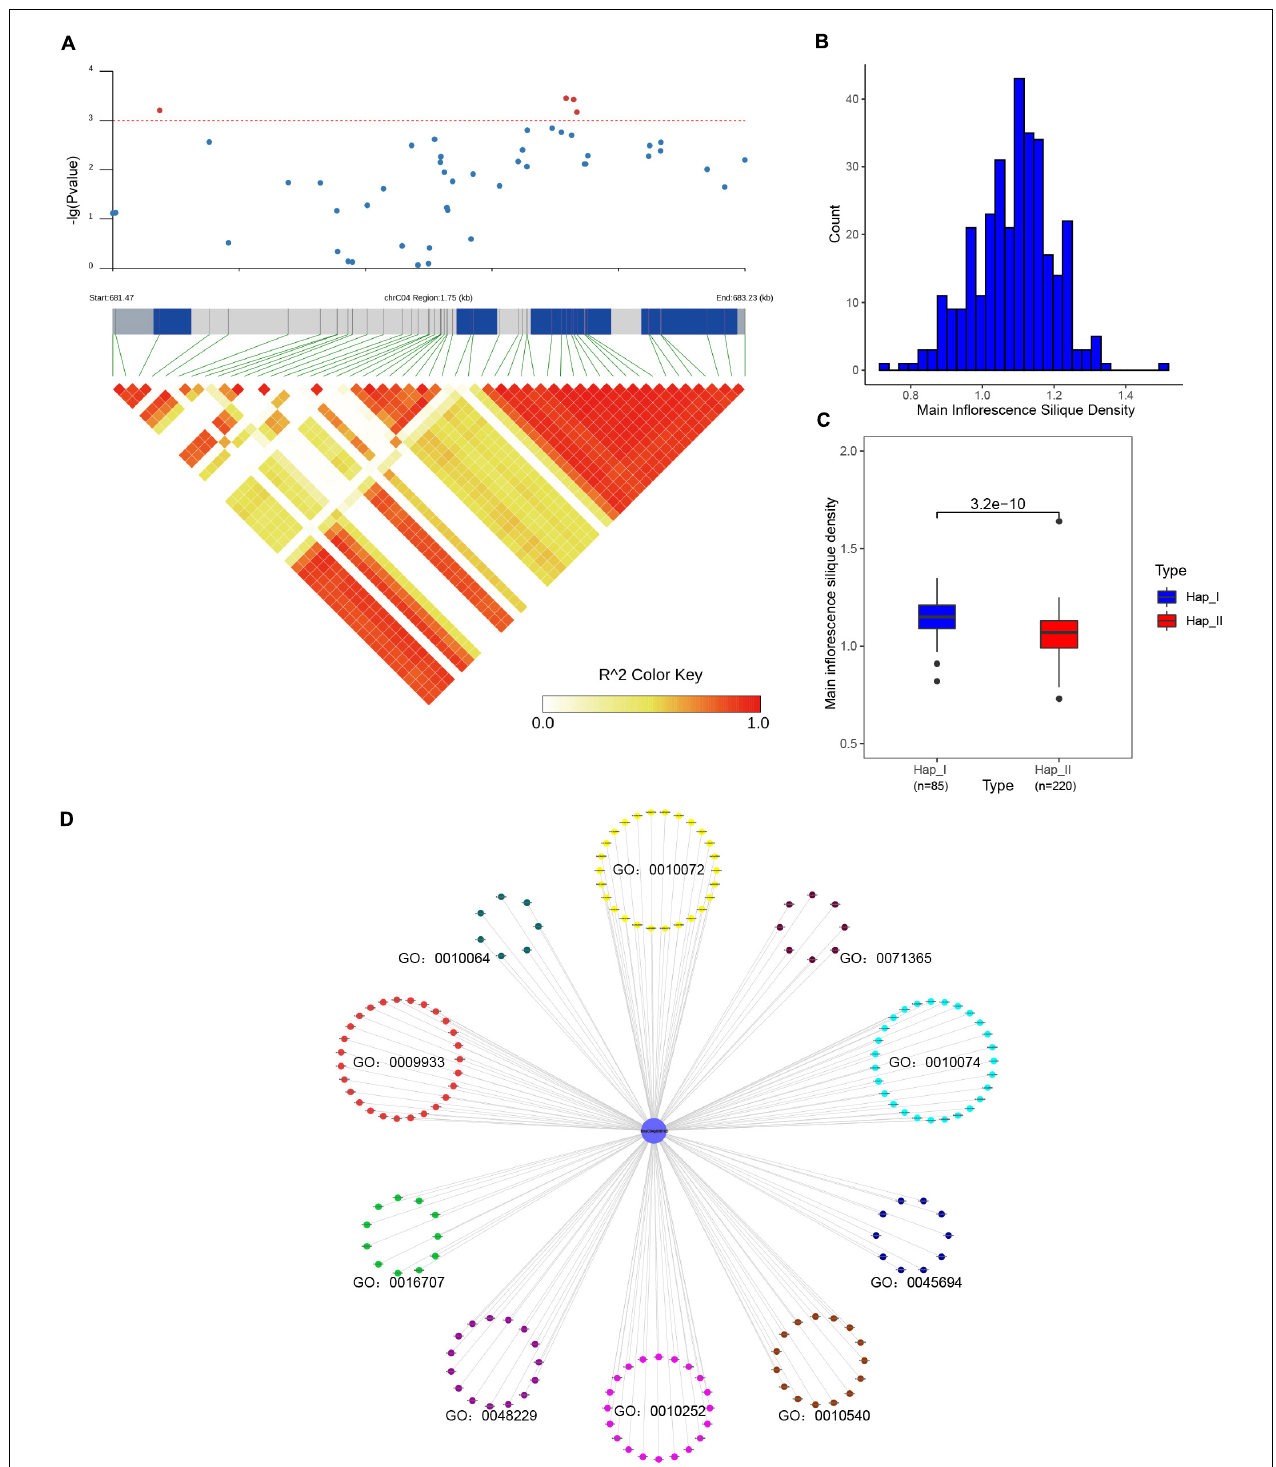
FIGURE 10 | Association mapping analysis of BnaC04g00810D in 324 core collections of B. napus germplasm. (A) BnaC04g00810D was significantly associated with main inflorescence silique density. (B) The distribution of main inflorescence silique density. (C) Comparison of main inflorescence silique density between the two haplotypes based on the most significantly associated SNP of BnaC04g00810D . (D) The enriched Gene Ontology terms of interacted proteins of BnaC04g00810D .